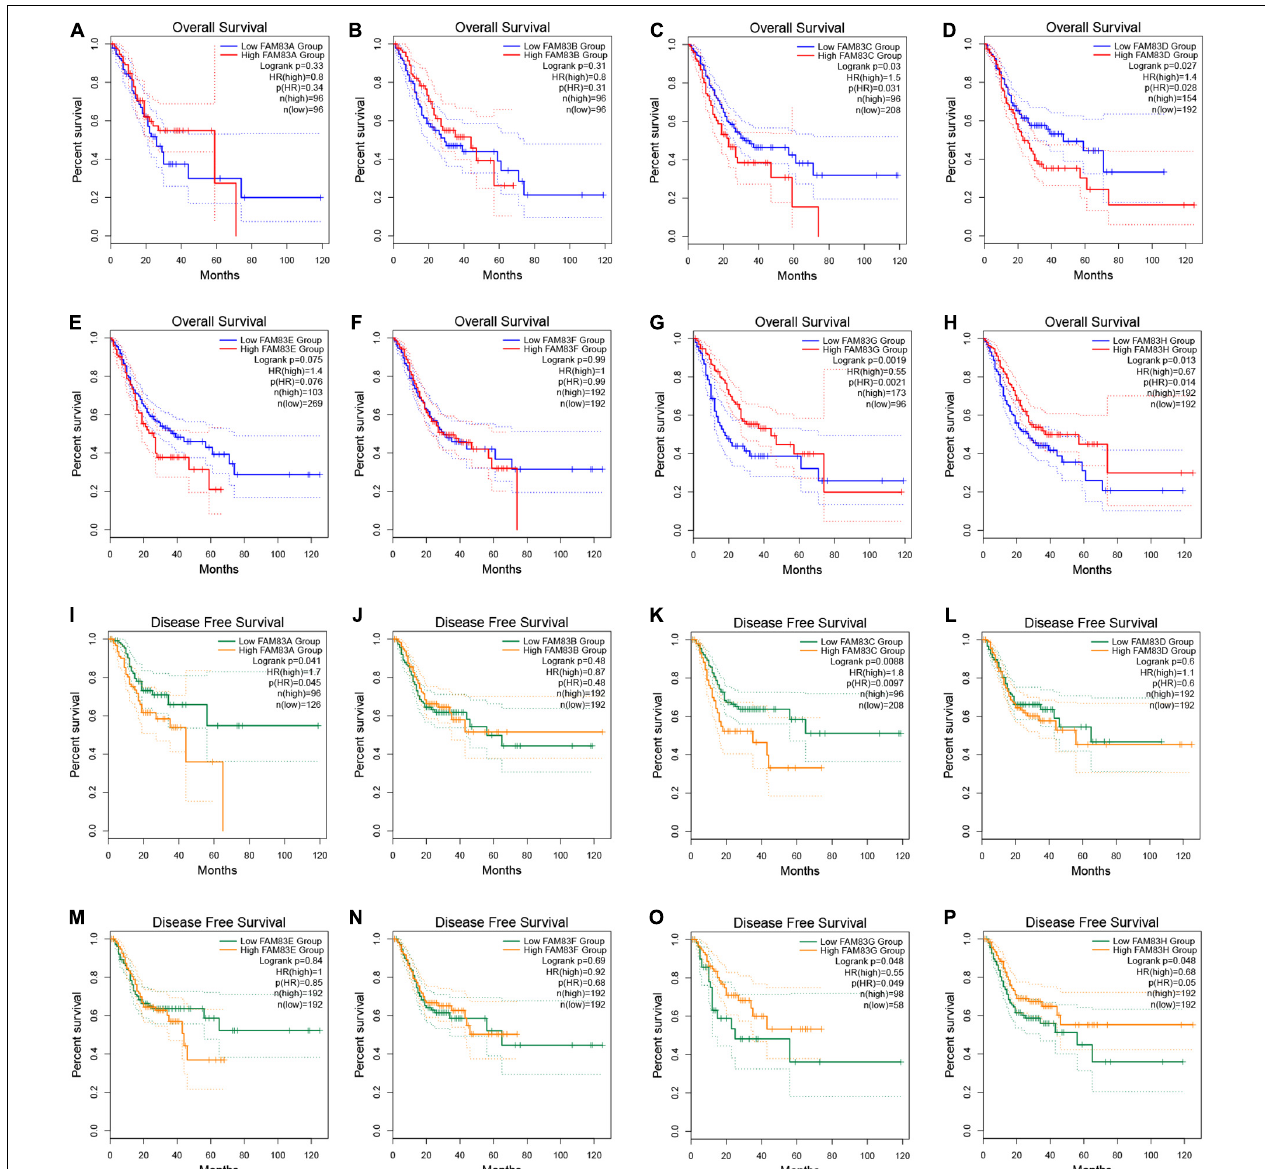
FIGURE 8 | (A–P) The prognostic value of FAM83 family members in STAD patients in the overall survival (OS) and disease free survival (DFS) curve